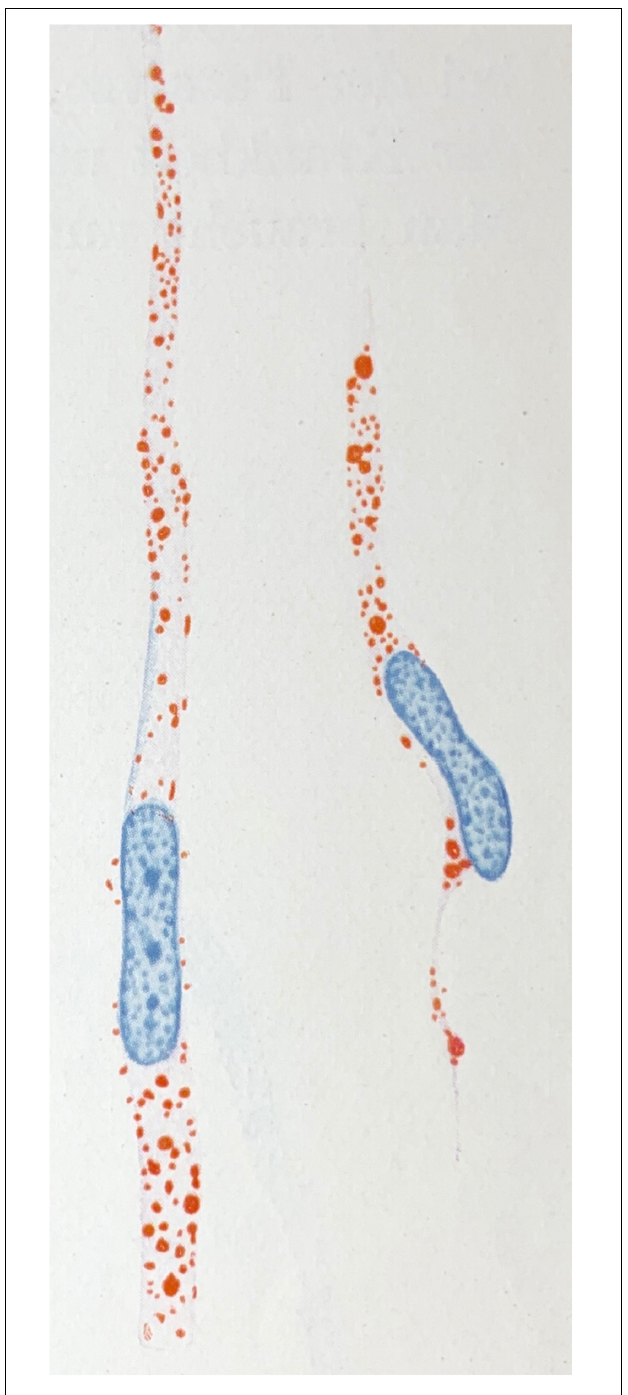
FIGURE 1 | Microglial rod cells rich in lipoid material (scarlet red staining; Sudan IV). Drawing taken from Spielmeyer (1922).